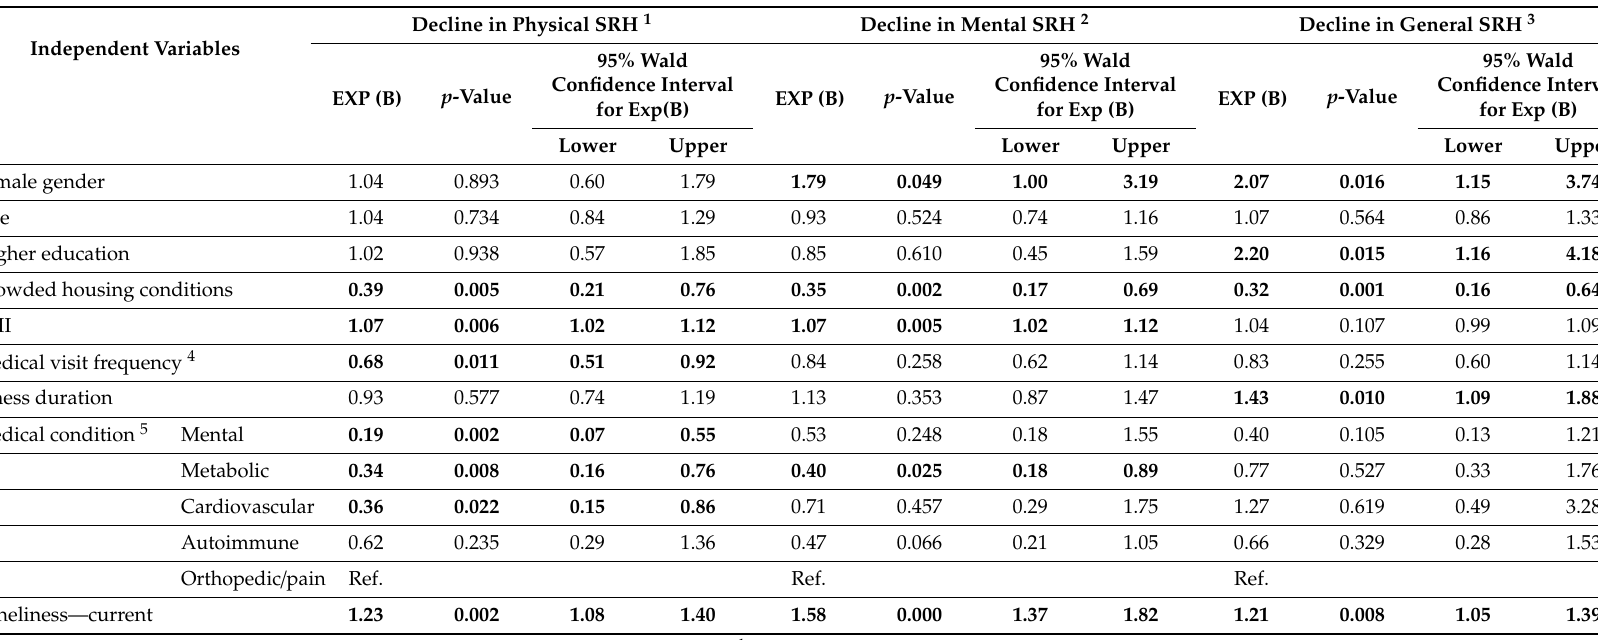
Table 5. Ordinal logistic regression predicting decline in self-rated health (SRH) one month into the Covid-19 outbreak among 292 people with chronic illnesses. Independent